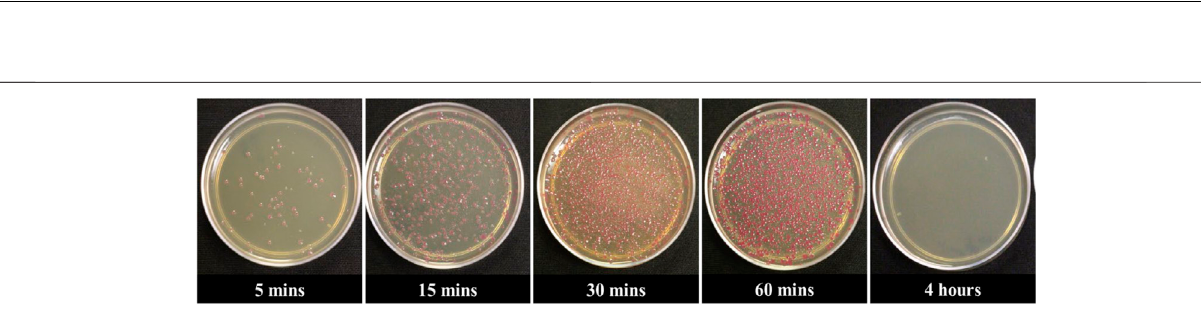
FIGURE 1 | DNA delivery by different carbon dots (Citric Acid + PEI, 100 µg; L-arginine and glucose, 66 µg; NH2-FCDs, 75 µg and COOH-FCDs, 50 µg) into the E. coli cells. Only the COOH-FCDs were able to carry the plasmid into the E. coli cells. Optimum incubation time for DNA delivery by COOH-CDs.